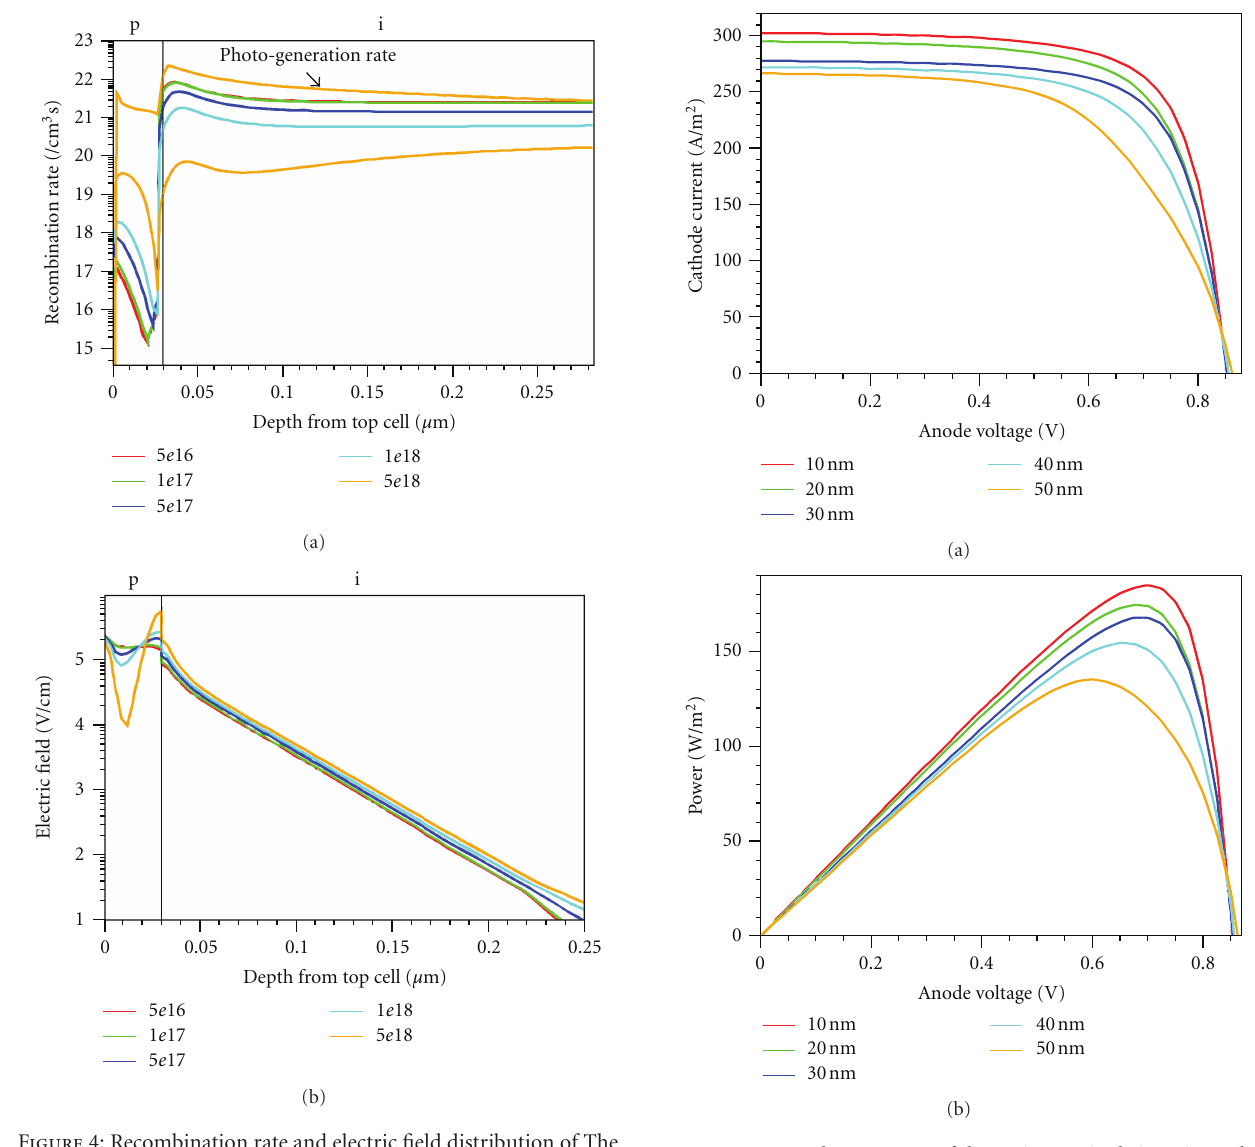
Figure 5: I-V and P-V curves of the a-SiGe:H single junction solar cell as function of thickness of